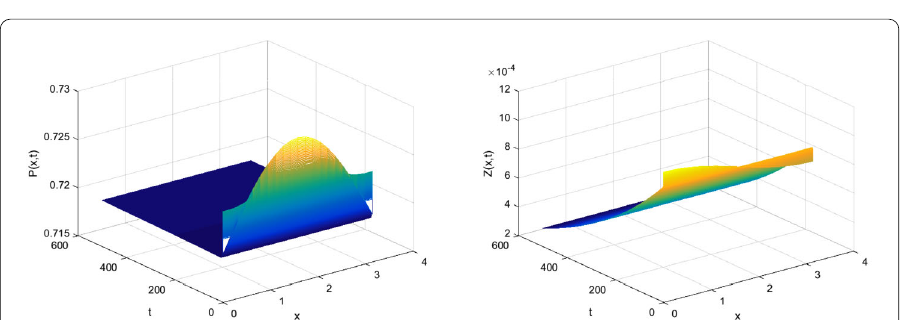
Figure 4 The numerical simulations of system (4.2) with E = 0.03 and initial condition